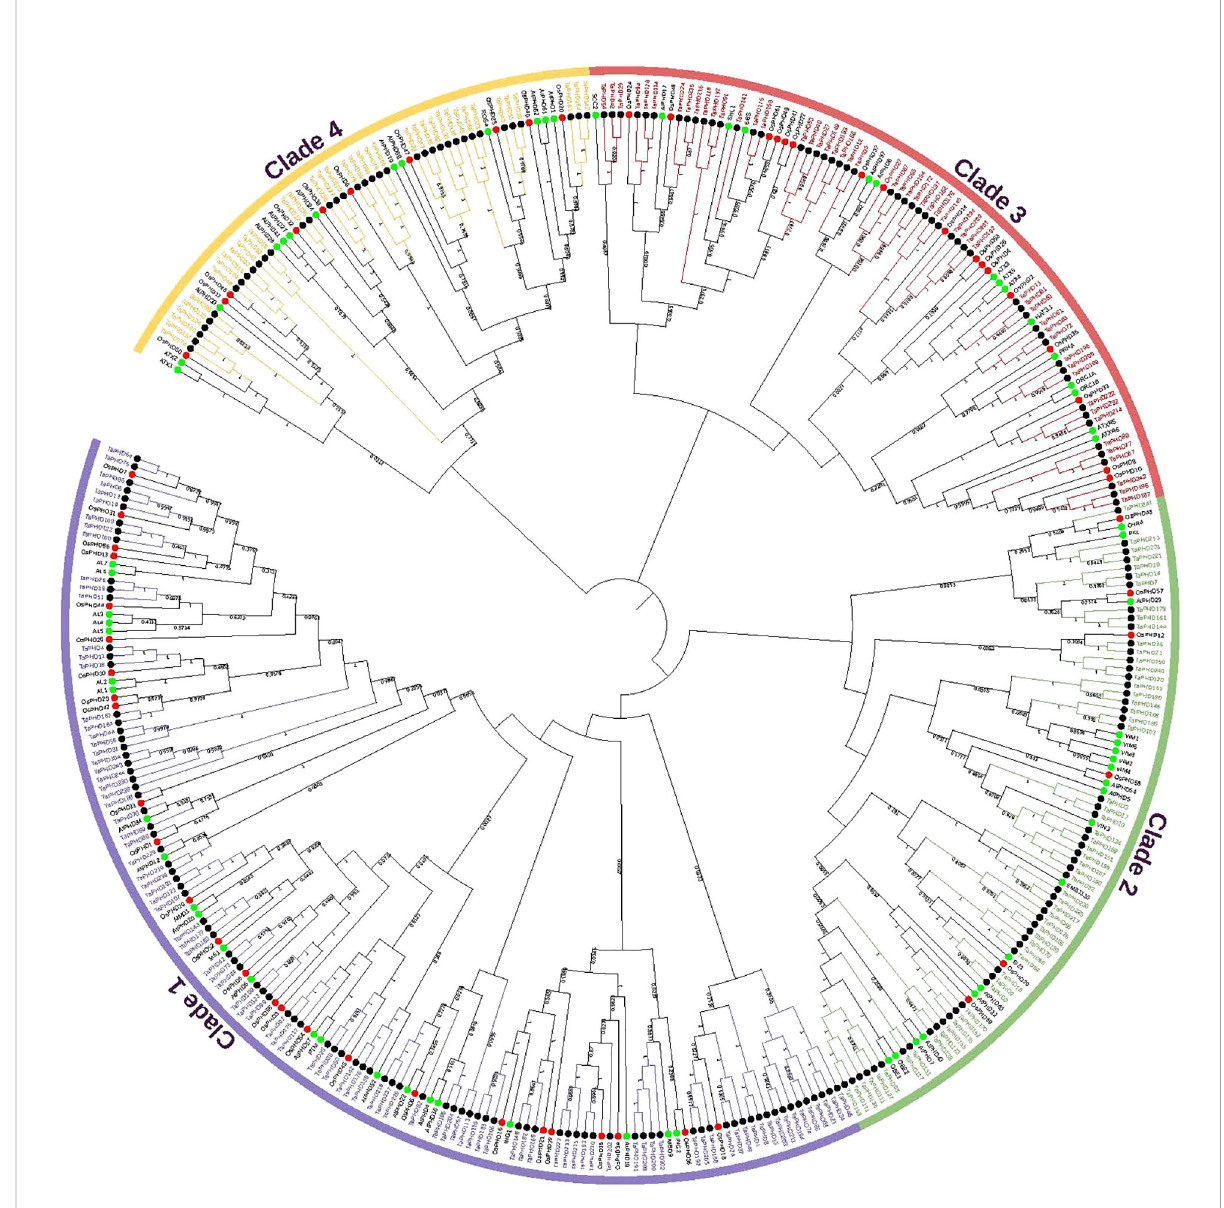
FIGURE 2 Phylogenetic tree of PHD genes in wheat, rice, and Arabidopsis . The tree was analyzed in MEGA X by using the neighbor-joining method. The PHDs from wheat, rice, and Arabidopsis are distinguished with black, red, and green dots. The PHD proteins were grouped into four distinct clades (clades 1-4), which are indicated by colored